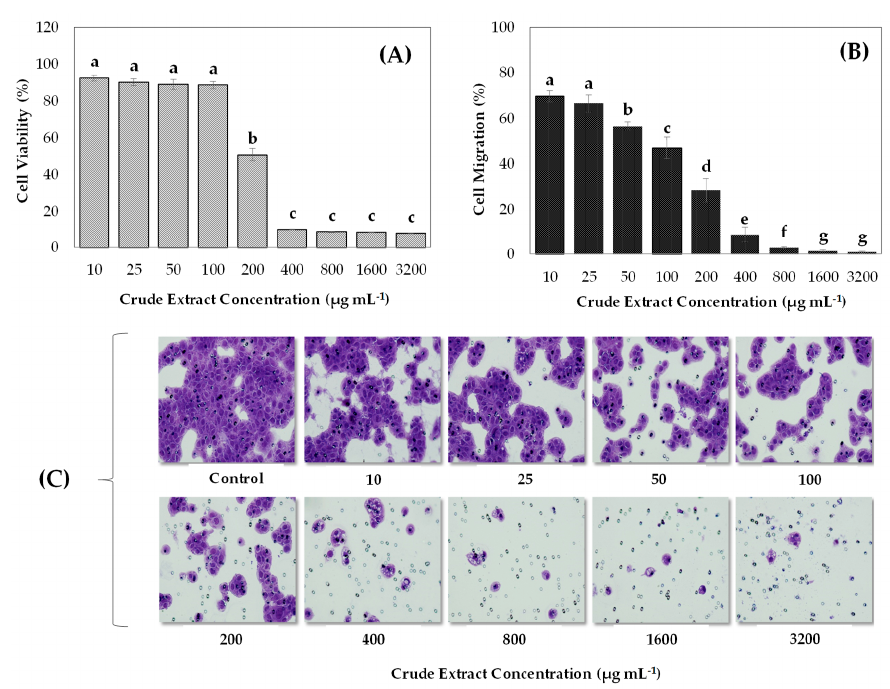
Figure 2. E ff ect of aqueous leaf crude extracts of blueberry plants treated with methyl jasmonate (MeJA) on cell viability ( A ) and cell migration ( B ) of the AGS gastric cancer cell line. Cell viability was measured after 24 h of extract incubation using AlamarBlue reagent and determining the fluorescence intensity at 530 / 560 nm. The percentage of viable cells relative to the control cells was calculated. To assess the migratory capacity, cells were exposed to increasing concentrations of leaf extracts during 1 h. The number of cells migrating in the presence of serum-free medium and Dulbecco’s Phosphate-Bu ff ered Saline (DPBS) bu ff er represented 100% of cell migration (control), whereas the values of cell migration after the extract exposure were calculated in relation to the control. Lower case letters (a–g) indicate significant di ff erences among the treatments according to the Tukey test ( p ≤ 0.05). Error bars represent the standard error of the data set. ( C ) Representative images of the e ff ect of each treatment on AGS cell migration under the light microscope and 20 × objective. Antioxidants 2020 , 9 , x FOR PEER REVIEW